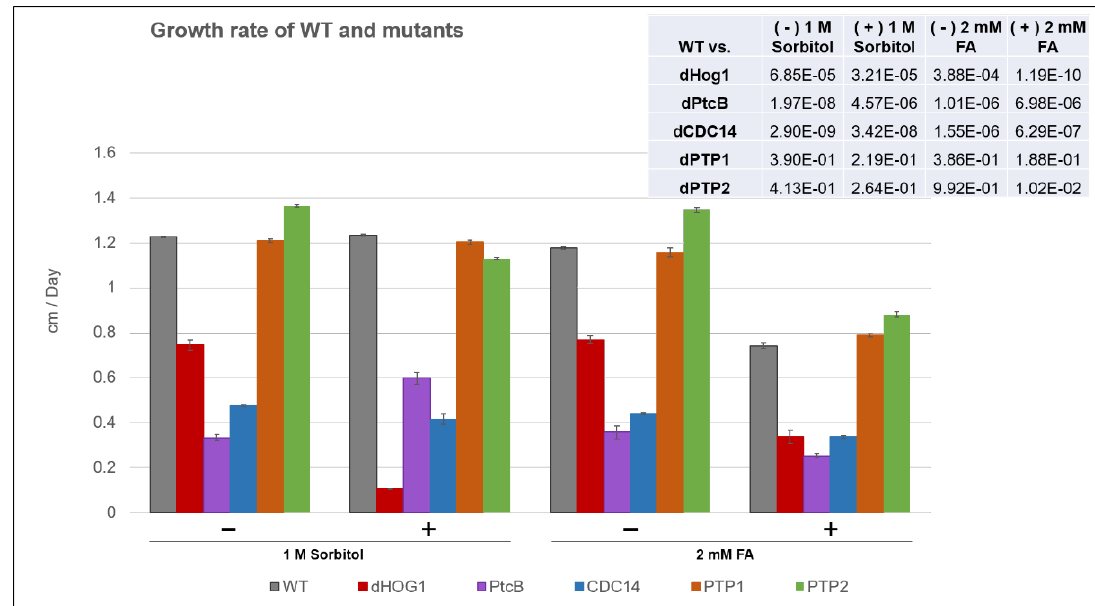
Figure 5. Morphology of the colony margins. The cultures were grown on CM agar plates with or without sorbitol (− or + 1 M sorbitol), or CM with 0.15% v/v DMSO with or without FA (− or + 2 mM FA). The pictures were taken 5 days after the inoculum transfer.